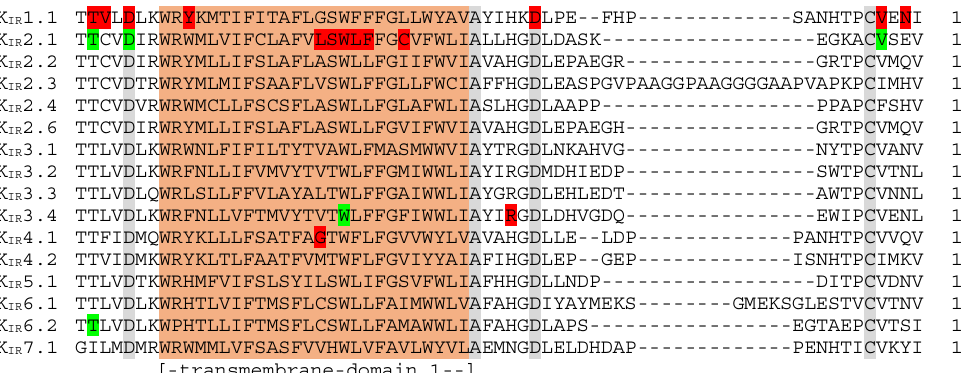
Figure 5. K IR 1–7 sequence alignment of the transmembrane domain 1 mutation hotspot. Red: mutations associated with aberrant tra ffi cking; Green: residues whose mutations are currently not related to impaired tra ffi cking. Numbers at the right refer to the last amino-acid residue in the respective sequence shown. Conserved residues among all K IR members are shaded gray. Location of the transmembrane domain 1 (orange) is indicated below the alignment.